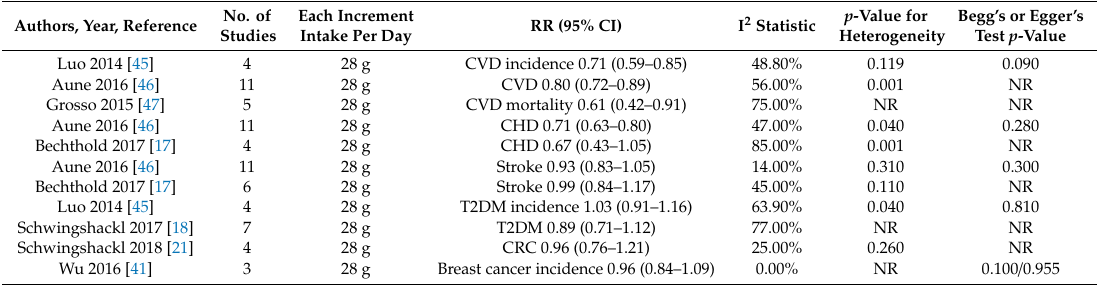
Table 7. Summary of linear dose-response meta-analyses of prospective studies on nut intake and CVD, CHD, stroke, T2DM, CRC, breast cancer.